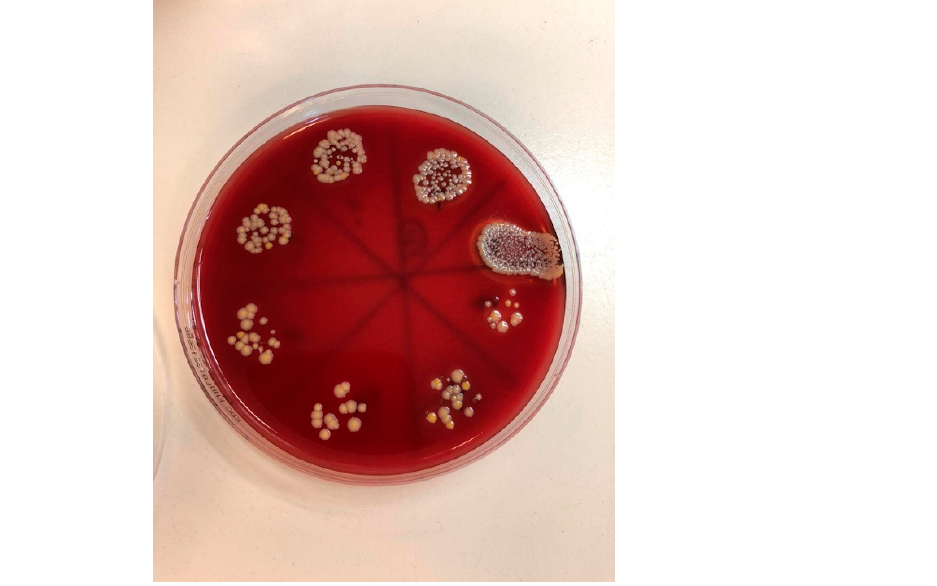
Figure 8. NC group—biofilm formation confirmed using SEM (5000×)—arrows showing microor ‐ ganism biofilm formation.